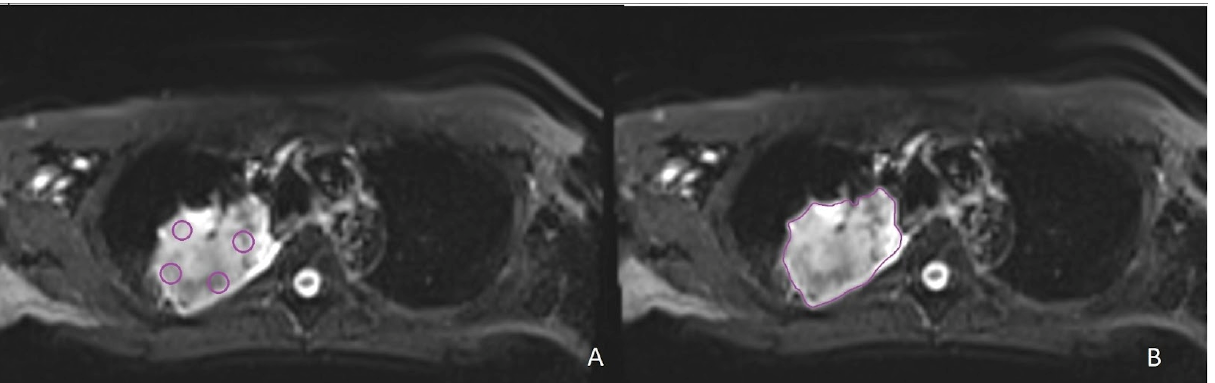
Figure 2. Examples of segmentations on intravoxel incoherent motion (IVIM) images in the same patient with non-small cell lung cancer localized in the right upper lobe. ( A ) Four fixed-size ROIs on the slice with the largest tumor diameter. ( B ) Freehand ROI on the slice with the largest tumor diameter.